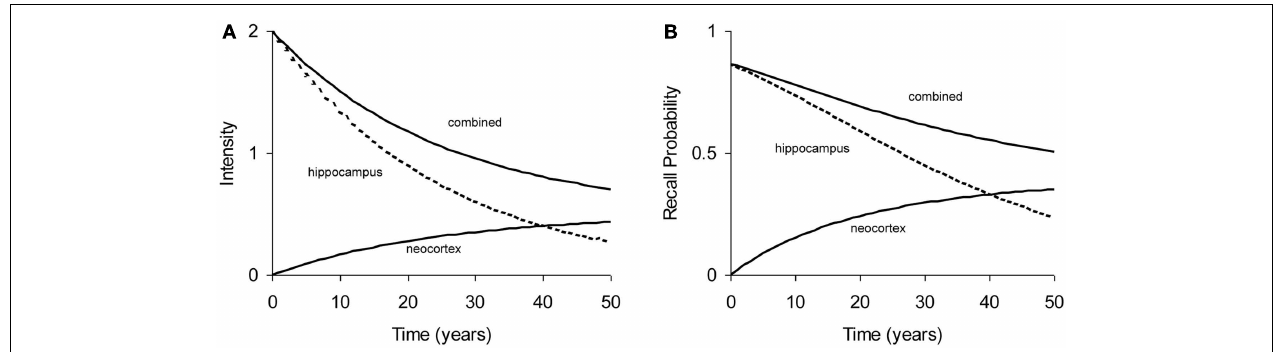
FIGURE 2 | Example of typical forgetting curve with simulated underlying processes in hippocampal and neocortical stores. (A) Intensity as a function of time. (B) Recall probability as a function of time.The curves in (A,B) are based on the same parameters.